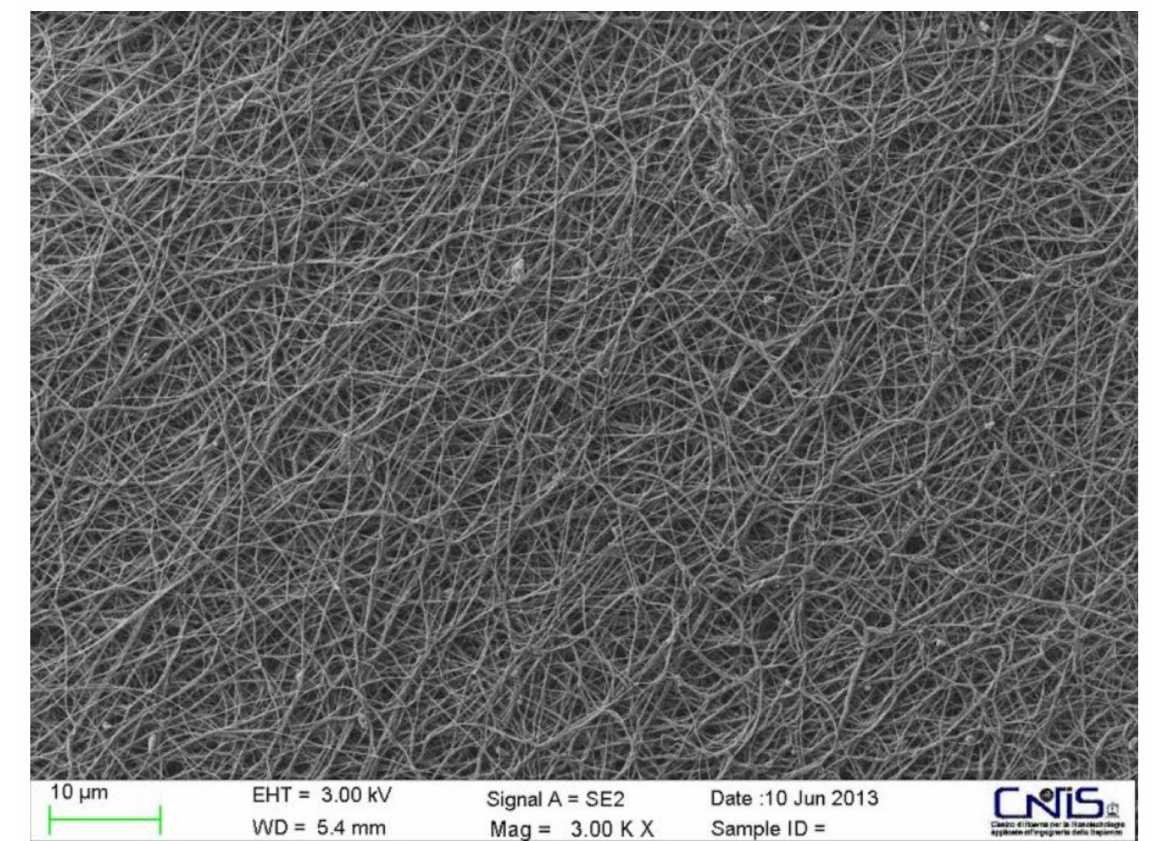
Figure 7. Chitin non-woven tissue ( up ) and its photo at SEM ( down ) where longer microfibers appear with the right interfibrillar porosity.